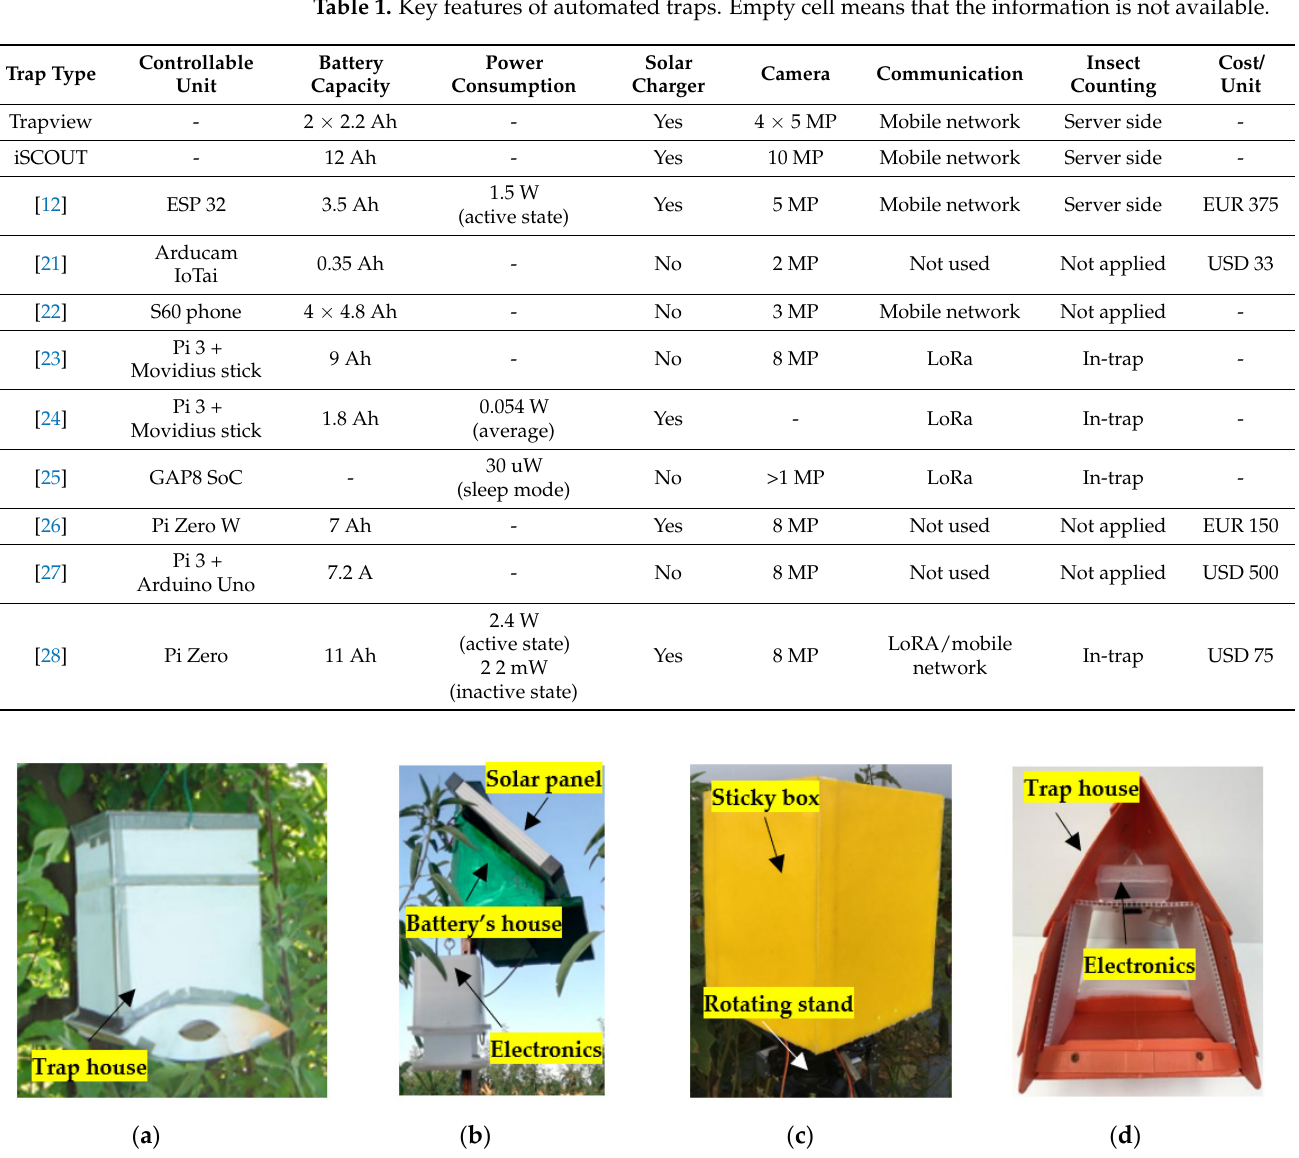
Table 1. Key features of automated traps. Empty cell means that the information is not available.